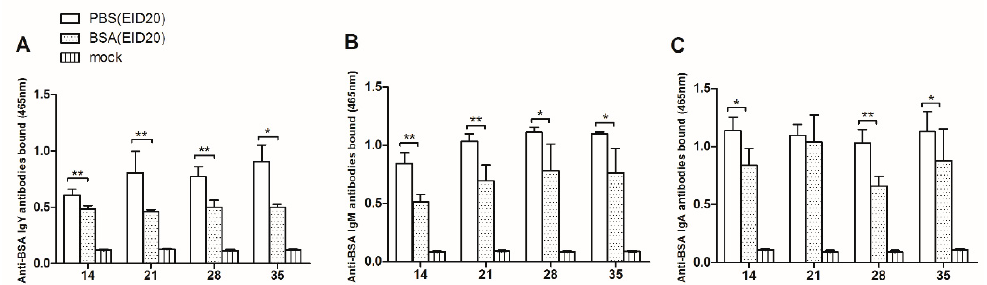
Figure 2. Serum anti-bovine serum albumin (BSA) antibody analysis after hatching: ( A ) the bound anti-BSA IgY antibodies; ( B ) the bound anti-BSA IgM antibodies; ( C ) the bound anti-BSA IgA antibodies. x-axis means chick age of days. y-axis means the OD value at 465 nm. The error bars indicate the SEM. * p ≤ 0.05; ** p ≤ 0.01.